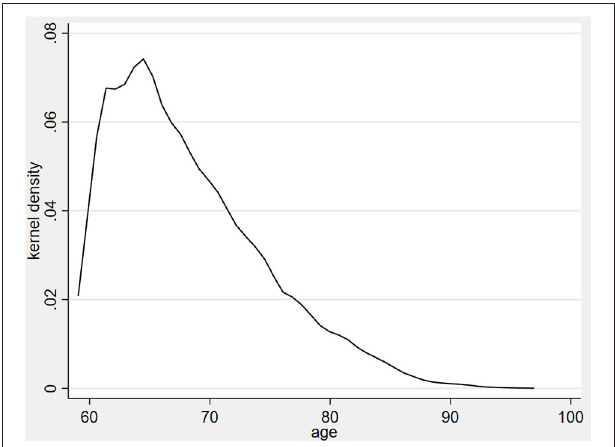
FIGURE 2 | Age distribution of the